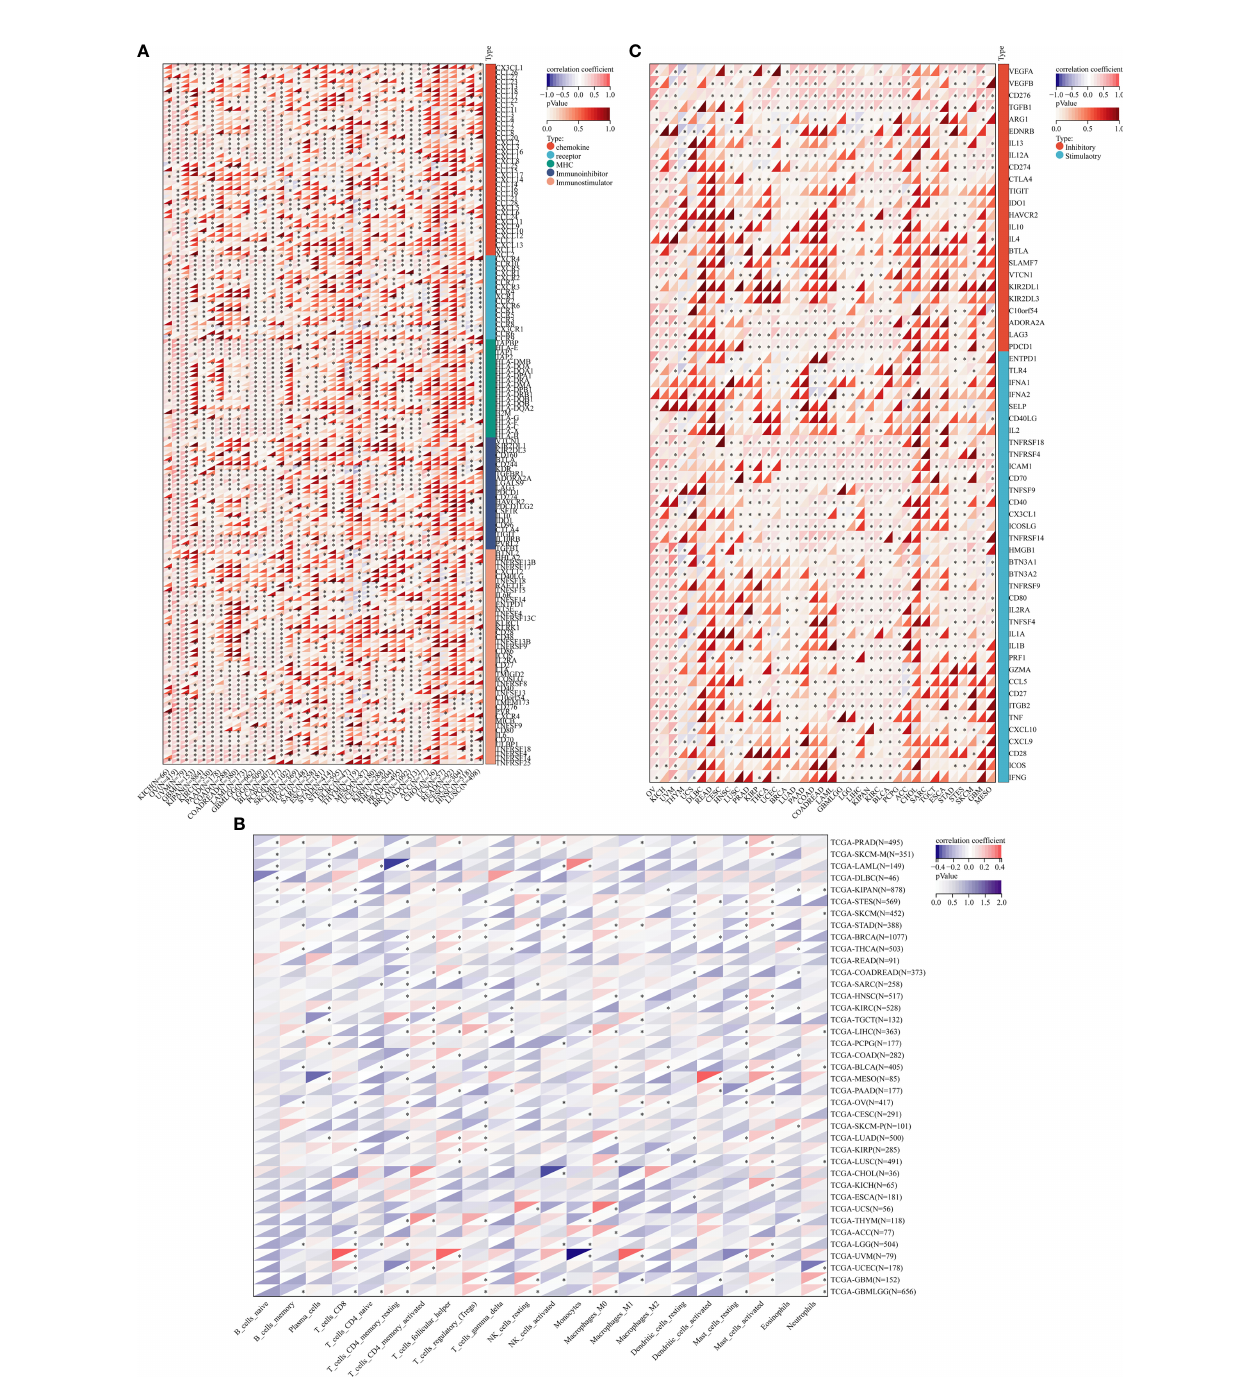
FIGURE 4 | Bioinformatics analysis of the immunomodulatory role of JMJD6 in pan-cancer. (A) Correlation between JMJD6 and 150 immunomodulators (chemokines, receptors, MHCs, immunoinhibitors, and immunostimulators). (B) Correlation between JMJD6 and 22 tumor-related immune cells calculated with the CIBERSORT algorithm. (C) Correlation between JMJD6 and 60 genes associated with immune checkpoints. * P <